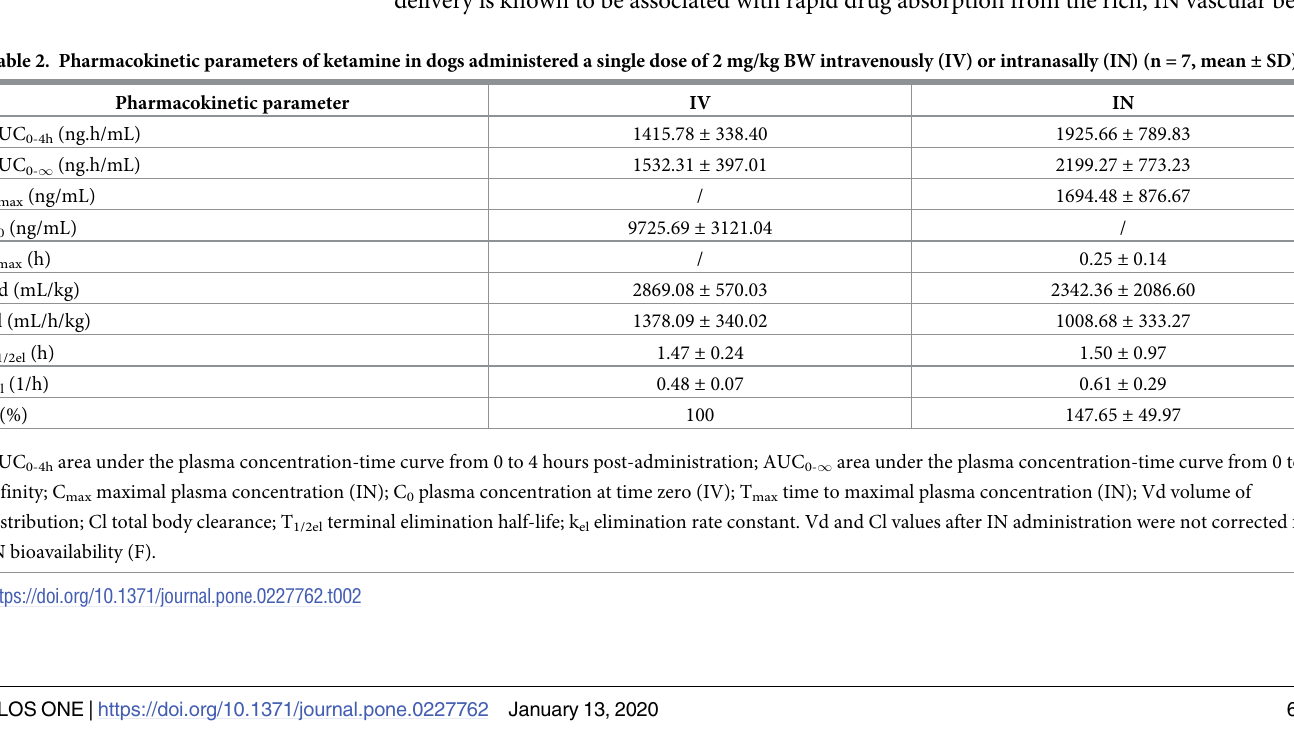
Table 2. Pharmacokinetic parameters of ketamine in dogs administered a single dose of 2 mg/kg BW intravenously (IV) or intranasally (IN) (n = 7, mean ± SD). Pharmacokinetic parameter